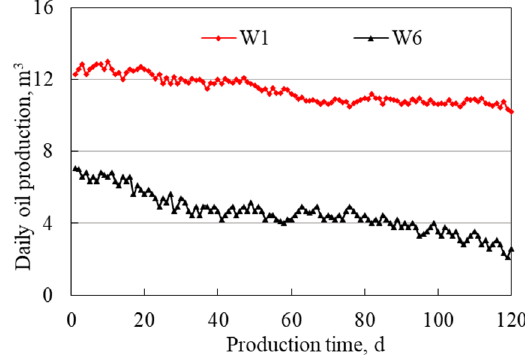
Figure 17. Daily oil production curve.